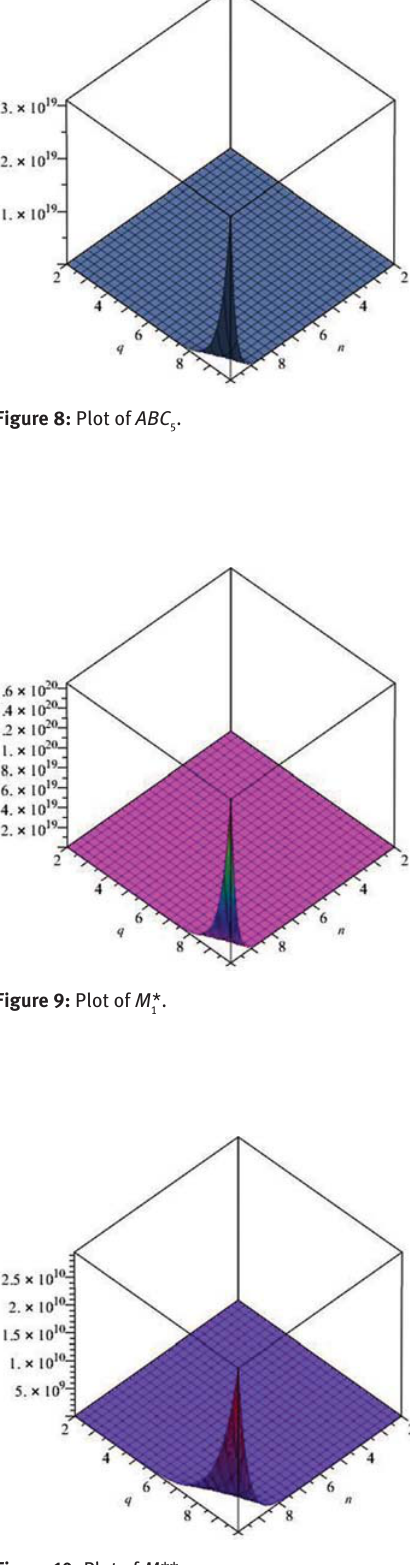
. Figure 10: Plot of M 4